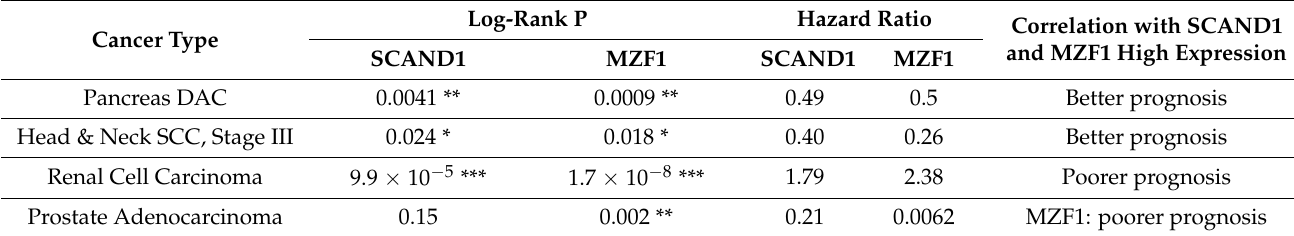
Table 2. Prognostic values of SCAND1 and MZF1 expression in